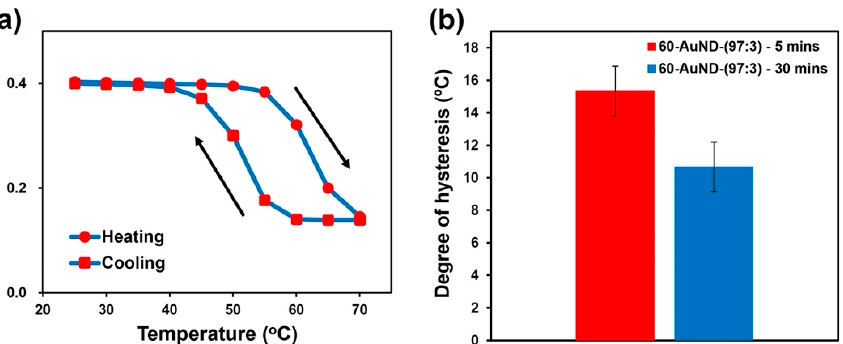
Figure 6. Rate-independent hysteresis of 60-AuND-(97:3): ( a ) the extinction values at 715 nm against temperature changes with a 30 min waiting time for 60-AuND-(97:3); ( b ) a plot of the degree of hysteresis during 5 and 30 min waiting times for 60-AuND-(97:3). The error bars represent standard deviation of the mean ( n = 3).